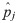
Top panel: Estimated σ and ρ as a function of p^j for 20 areas in Greenland et. al [12], with loess smooth overlayed.Bottom panel: Solid line represents OC curve for n = 60, d = 50 for p
l = .75, p
u = .9 design when σ and ρ are fixed at the mean value of σ^ (left) and ρ^ (right). Dashed line represents OC curve when σ and ρ vary over p according to the predicted loess smooth of σ^ (left) and ρ^ (right).